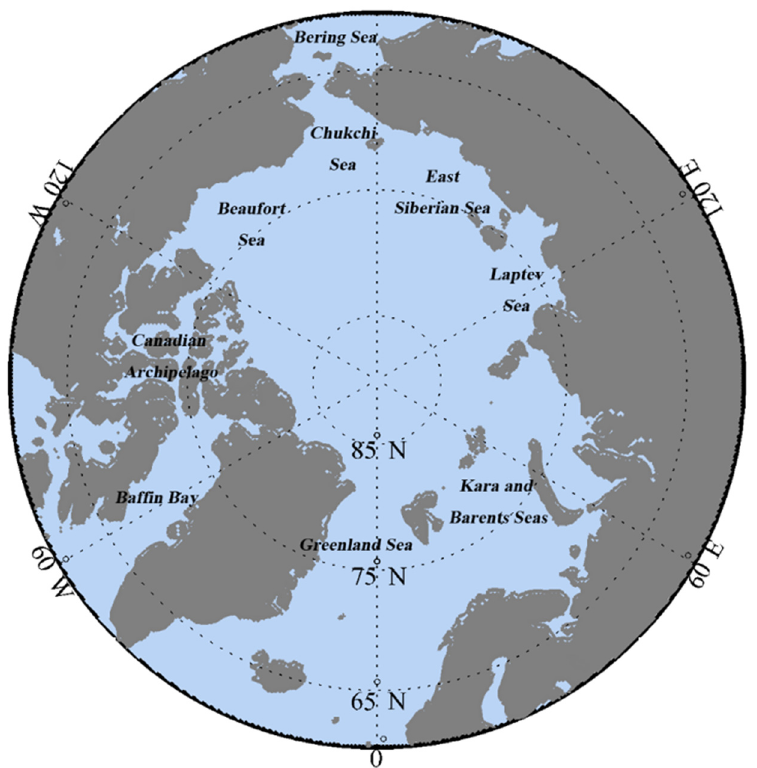
Figure 1. Study regions (light blue) from 60°N to 90°N. The land areas are masked in